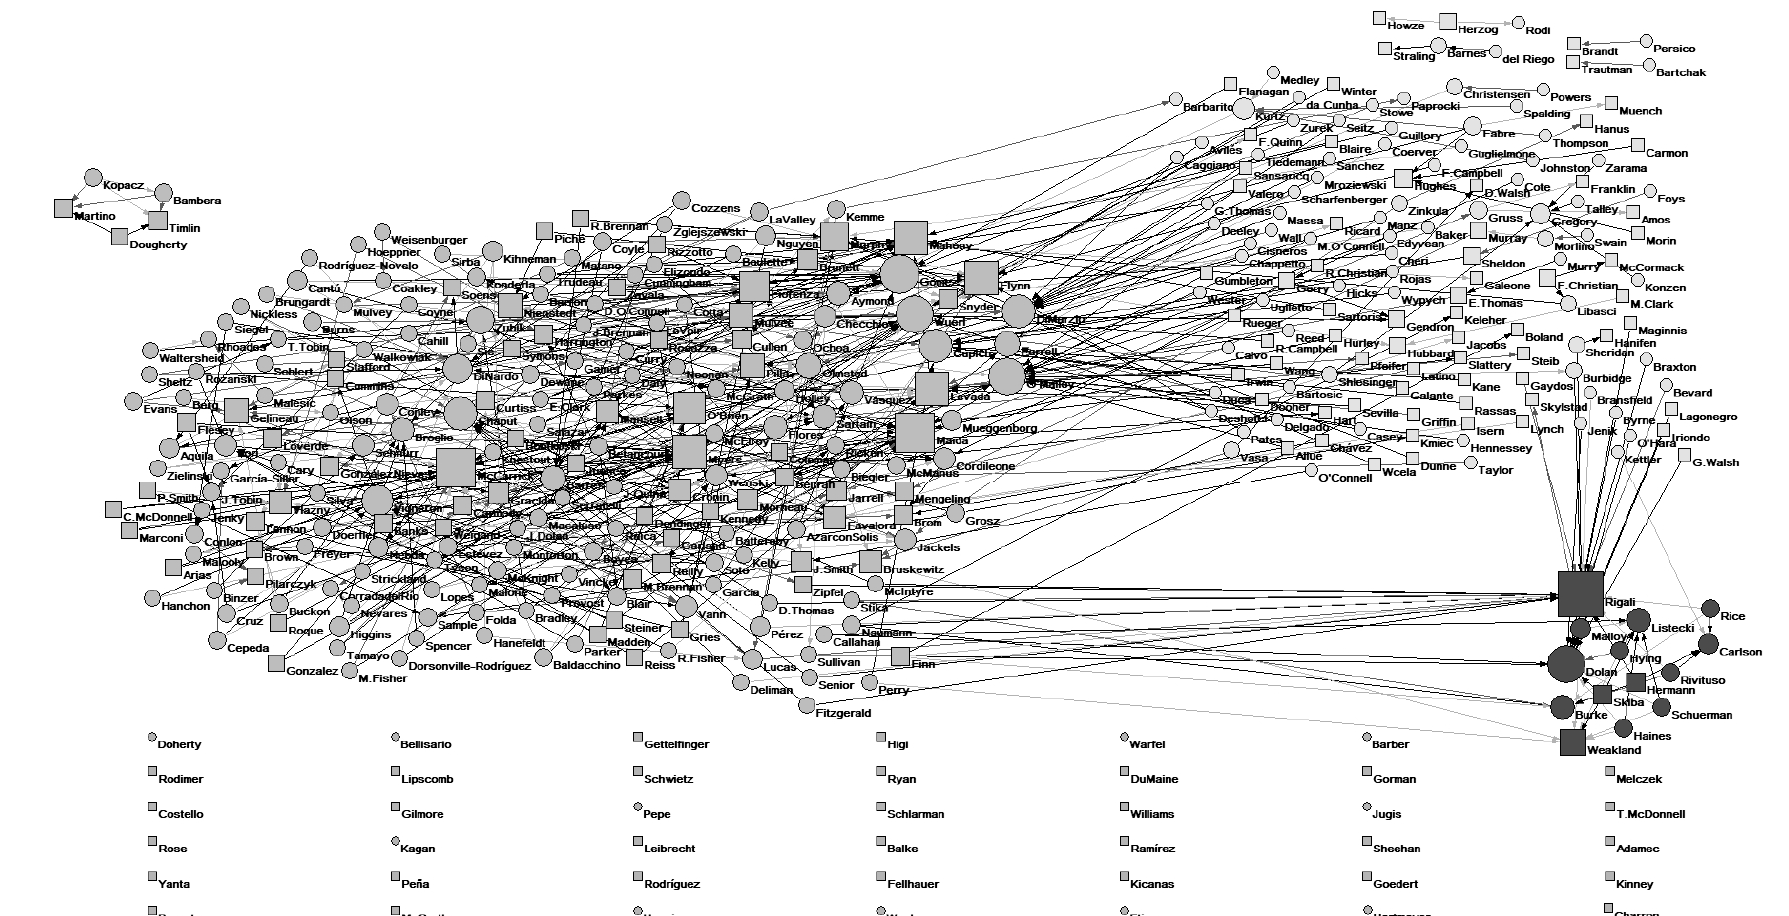
Figure 2. Visualization of US bishops’ network using K-Core ( k = 3) (July 2018).